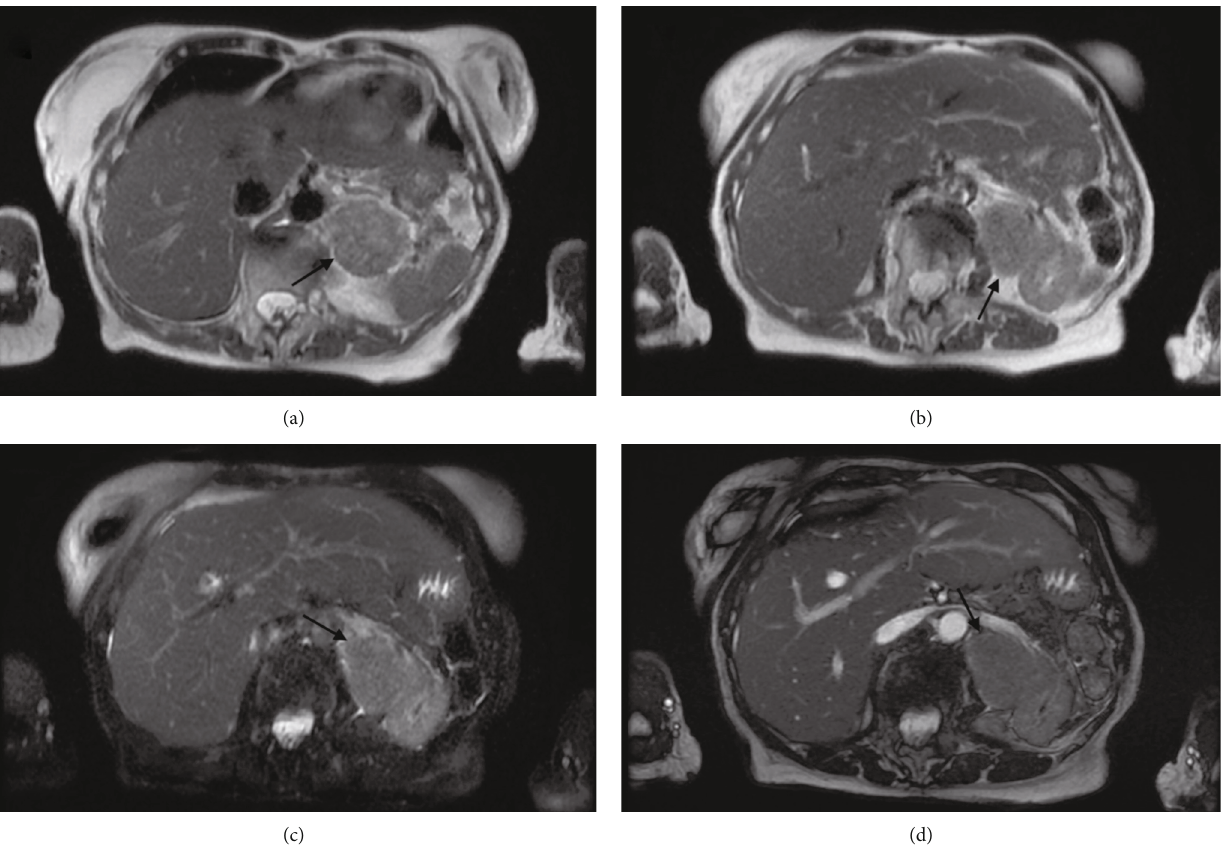
Figure 2: Follow-up MRI, ten months later, showed signi fi cant enlargement of the left adrenal mass, measuring 6 : 5 × 5 : 1 × 5 : 0cm .